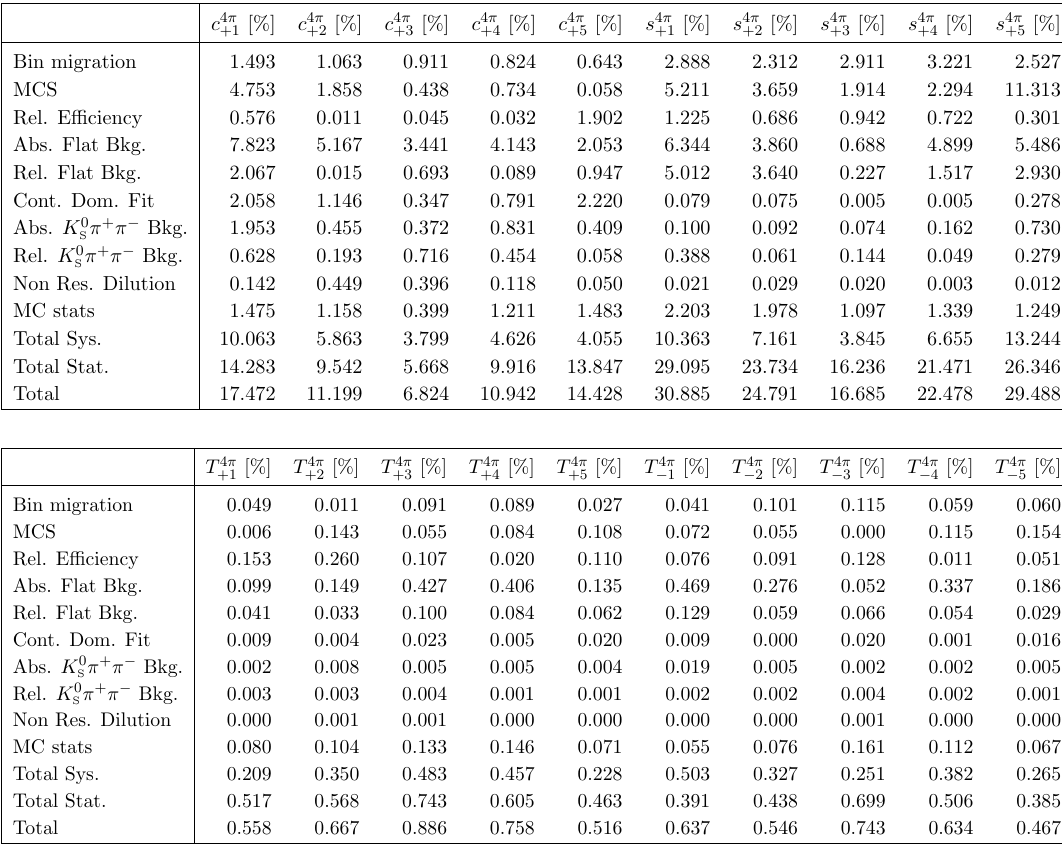
Table 5 . A breakdown of the systematic uncertainties for the optimal alternative binning scheme with N = 5.